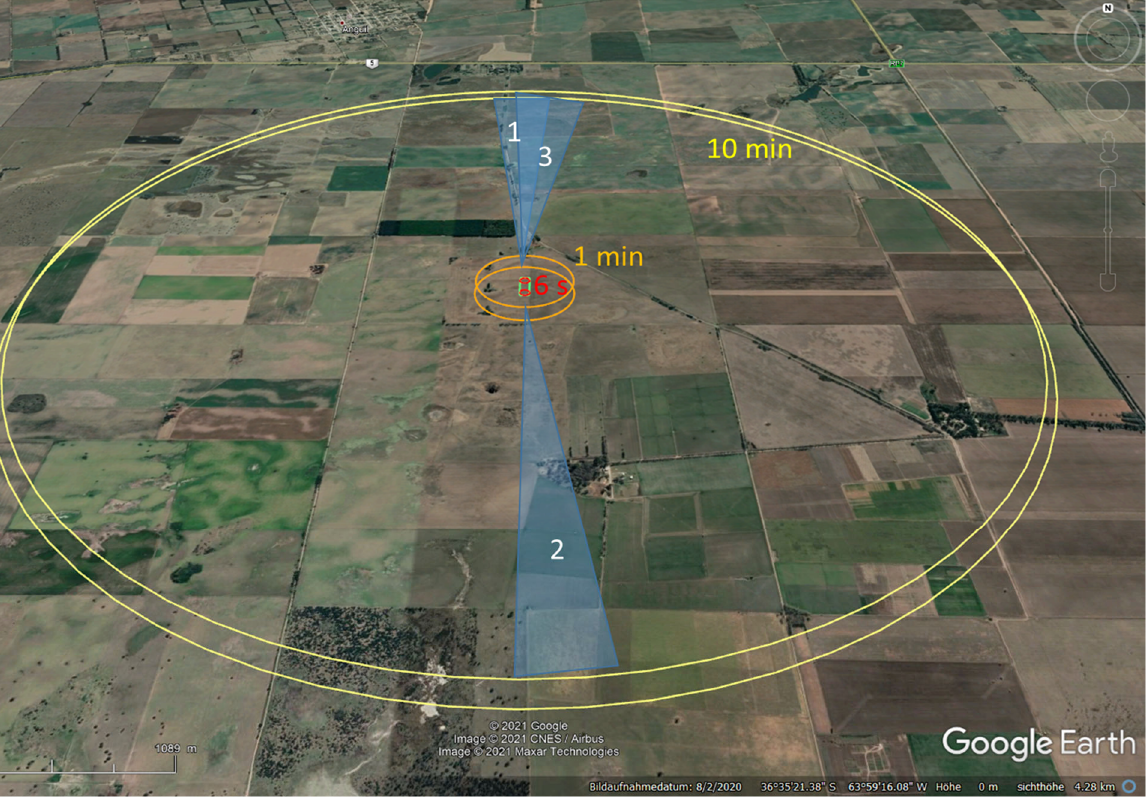
Figure 1. Location of the measuring field and travelled distance of air and particulate matter for both measuring points at the test field (green rectangle) for a wind velocity of 6 m s − 1 and different measuring intervals (red circles: 6 s—highest temporal resolution of the EDM164; orange circles: 1 min—regular interval of the EDM164; yellow circles: 10 min—common interval of long ‐ term meteorological measurements); blue sectors mark the wind directions of the three considered events.